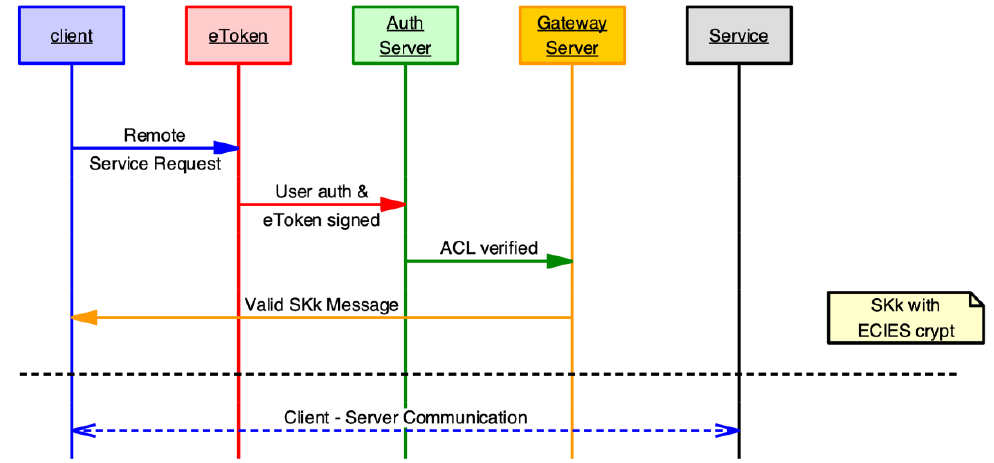
Figure 4. Message sequence chart (MSC) between the elements of the system.